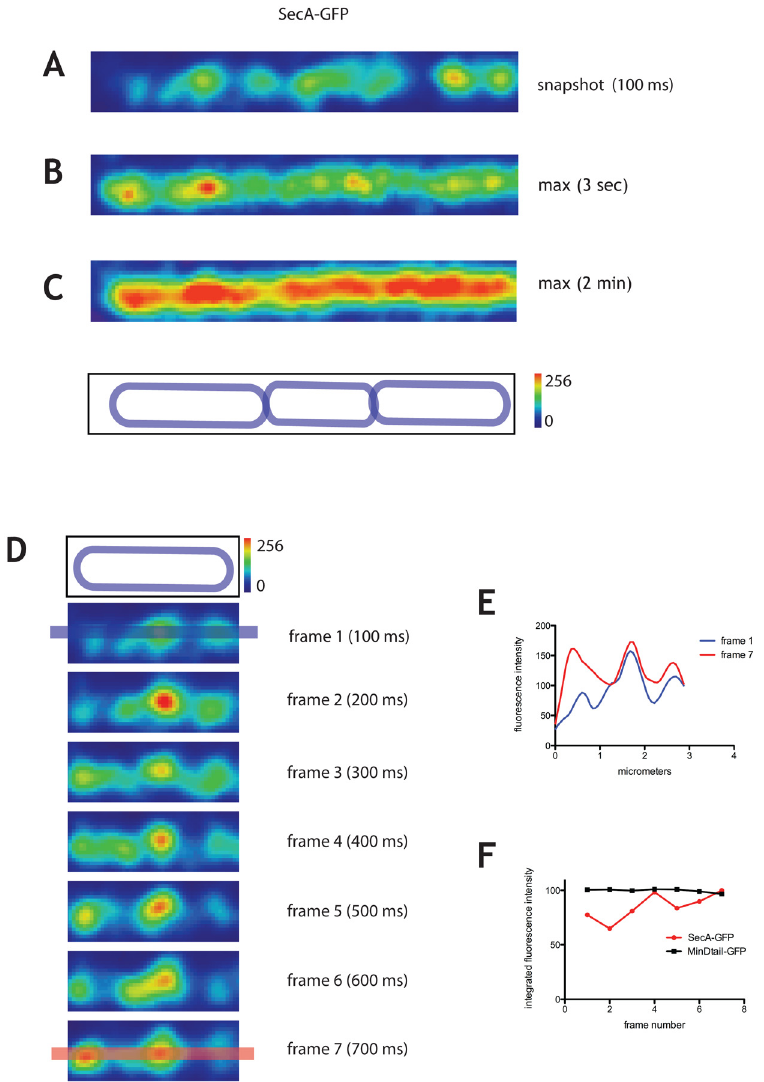
Fig 1. Dynamics of SecA-GFP imaged by TIRF. SecA-GFP (strain secA::pSAG2) imaged by TIRFM. Time series were taken over 2 min in streaming mode using 100 ms integration time. A typical cell is displayed with ‘ physics ’ LUT from FIJI (see Materials and Methods). A. 100 ms snapshot. B. and C. Typical 3 s (B) and 2 min (C) maximum projections showing average localization of SecA-GFP over these timescales. The outline of the cells is shown above the panels (see Materials and Methods). The intensity scale for fluorescence is shown on the right of the cell outline panel; it also serves as a scale bar of 1 μ m. D. Successive frames of the first cell on the left from panel A over a 700 ms time window. The top panel is the cell outline. Intensity scale for fluorescence is 1 μ m. E. Fluorescence intensity profiles along the line drawn over the long axis of the cell shown for frames 1 and 7, as shown in blue and red respectively in panel D. F. Integrated fluorescence intensities for the entire surface of representative cells expressing SecA-GFP (in red) and GFP stably attached to the membrane via the membrane binding tail of MinD (MinDtail-GFP, in black) (see also S1 and S3 Figs).